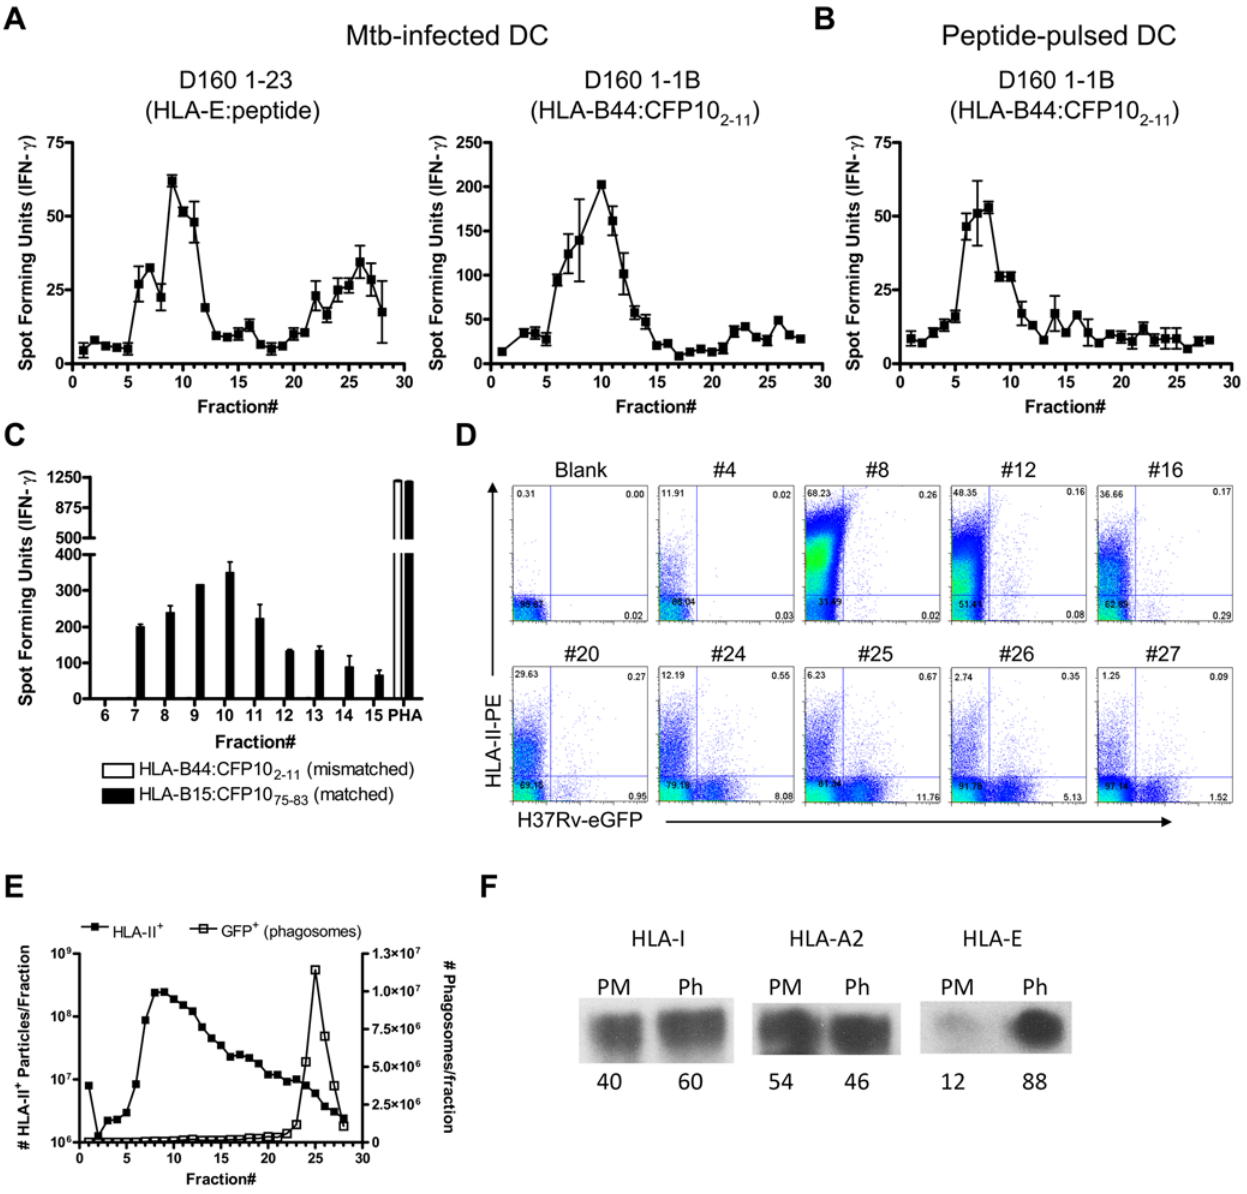
Figure 6. HLA-E:peptide complexes are present in phagosomal fractions. (A,B) DC were pulsed with H37Rv-eGFP or CFP10 2–11 peptide and the homogenate was separated using 27% percoll as described. Each fraction was freeze-thawed and tested for its ability to stimulate D160 1-23 (A) or D160 1-1B (A&B) CD8 + T cell clones in the absence of additional APC. IFN- c production was measured using ELISPOT. The mean 6 SEM of duplicate wells is presented. Data are representative of four experiments at various timepoints in A, and four experiments after a one hour peptide pulse in B. (C) Plasma membrane/ER fractions from Mtb–infected DC (HLA-B15 + /HLA-B44 2 ) were incubated with HLA-I matched or mismatched CD8 + T cell clones and IFN- c production was measured using ELISPOT. The mean 6 SEM of duplicate wells is presented and data are representative of three experiments done similarly. (D,E) Individual fractions were analyzed by flow cytometry to assess HLA-II-PE (plasma membrane) and H37Rv-eGFP fluorescence. Selected fractions are shown (D) including the peak plasma membrane fraction ( # 8) and phagosomal fractions ( # 24–27). Prior to flow cytometry, fractions were mixed with a reference latex bead population at a known concentration. Equal numbers of latex bead events were collected for all fractions and used to quantify the number of plasma membrane and phagosome particles (E) as described in Materials and Methods. (F) HLA-I was immunoprecipitated from plasma membrane or phagosome fractions using W6/32. After dilution of the plasma membrane sample to give similar levels of HC10 staining, the presence of HLA-I alleles was assessed using antibodies to pan-HLA-I (HC10), HLA-A2 (HCA2), and HLA-E (MEM-E/02). The numbers below blots indicate the relative intensity of the bands as described in Materials and Methods. doi:10.1371/journal.ppat.1000374.g006 the pan-HLA-I antibody, W6/32, and HLA-I levels in normalized to give roughly equivalent intensity bands for total each compartment were compared by western blot using HLA-I levels (HC10). While the blots for HLA-A2 are similar to three different HLA-I antibodies. Because HLA-I levels are that for HC10, the intensity of HLA-E is increased over seven- greatly increased on the plasma membrane compared to the fold in the phagosome (Figure 6F). These data support the phagosome, the immunoprecipitate from plasma membrane was functional data that HLA-E complexes are more easily detected